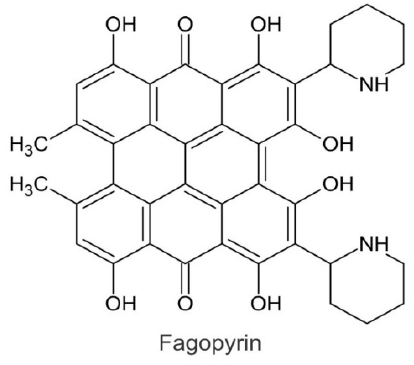
Figure 3. Molecule of fagopyrin.